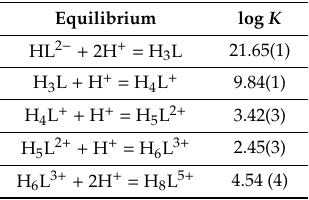
Table 1. Protonation constants of H 3 L (aqueous solution; 0.1 M NaCl; 298.1 ± 0.1 K). Values in parentheses are standard deviations on the last significant